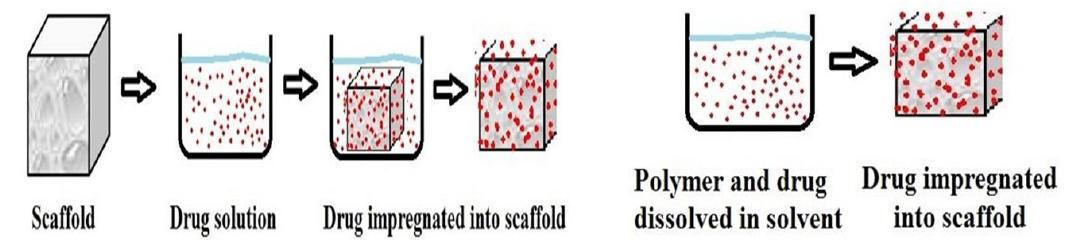
Figure 21. The formation of the system during fabrication. Reproduced with permission from [1].